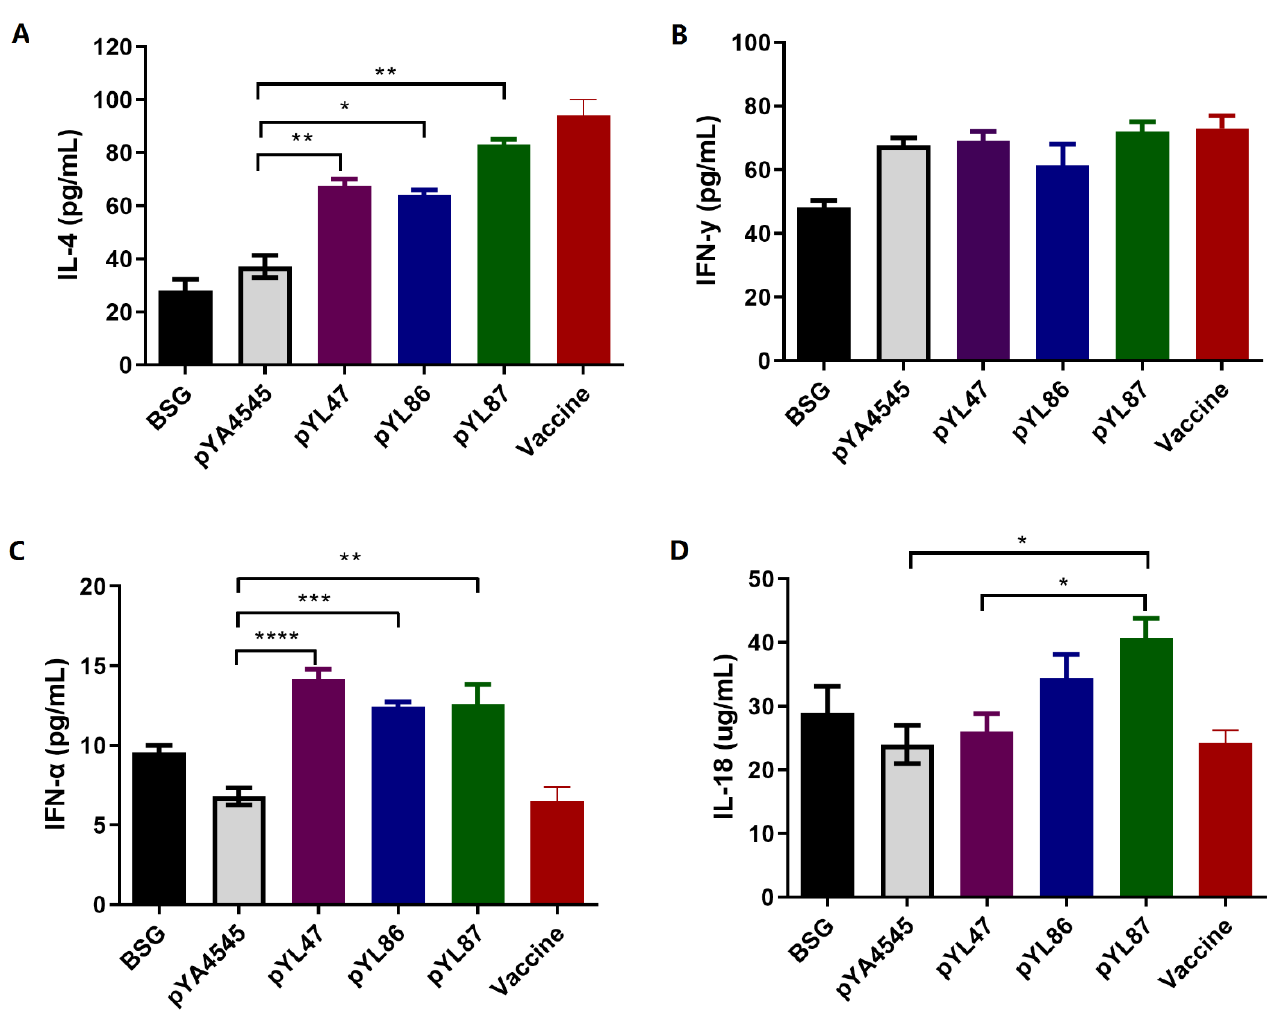
Figure 5. Production of IL-4, IFN-g, IL-18, and IFN-a cell supernatants stimulated with purified HN protein. The concentrations of IL-4 ( A ), IFN-g ( B ), IFN-a ( C ), and IL-18 ( D ) were determined by ELISA assay. The results are indicated as means ± SEM ( n = 3). The statistical significance was calculated by one-way ANOVA and a Tukey post-test. * p < 0.05; ** p < 0.01; *** p < 0.001; **** p < 0.0001.